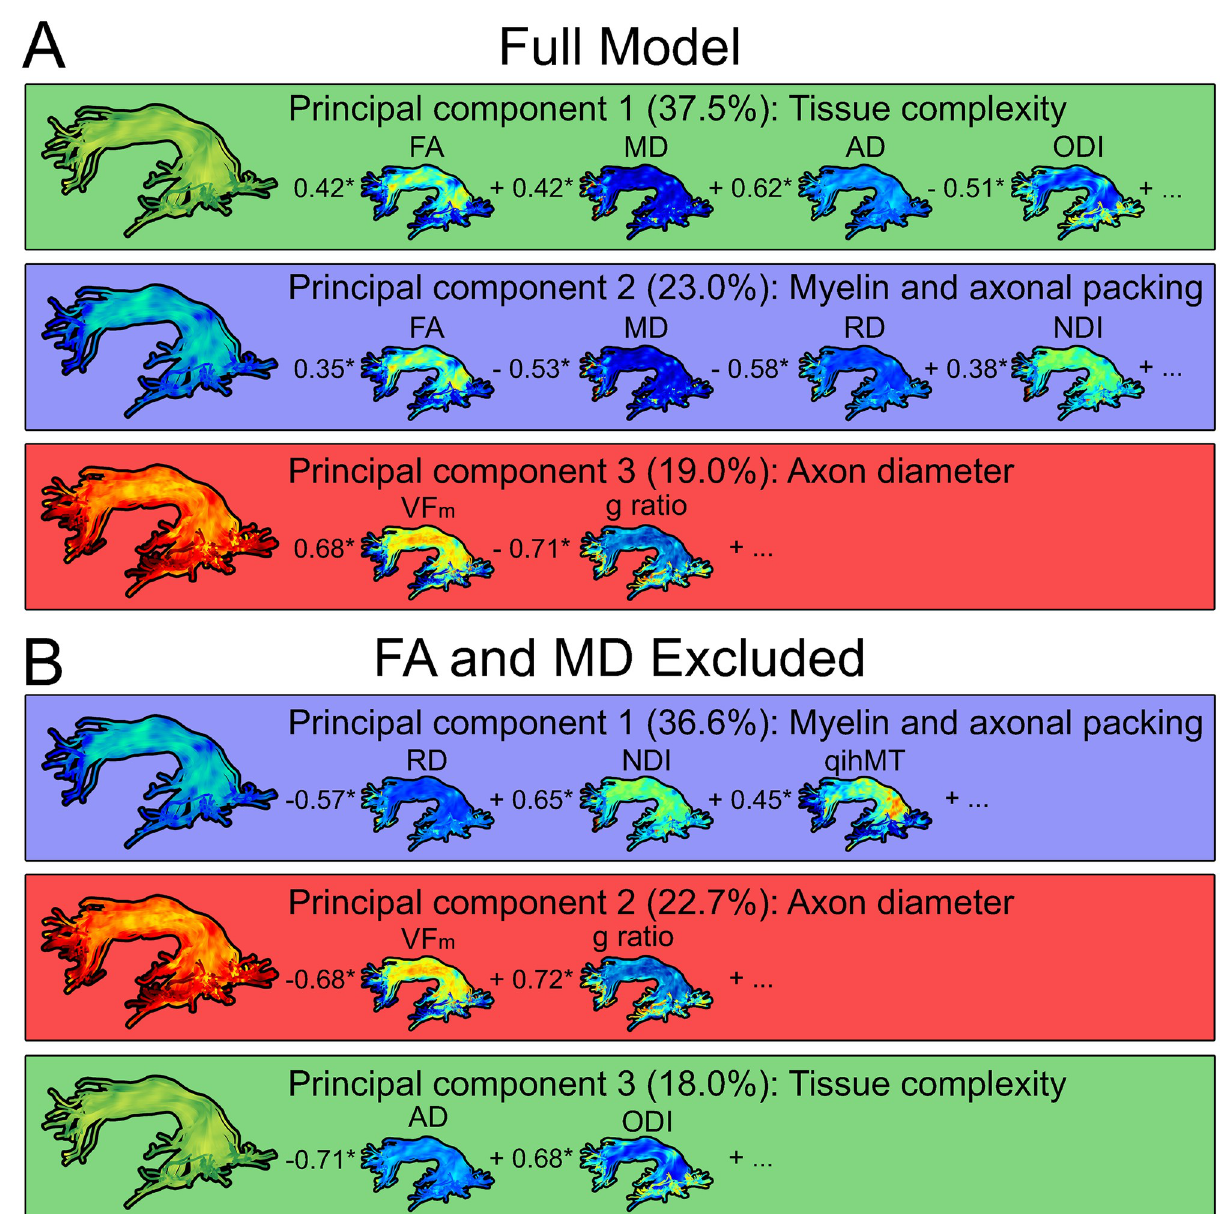
Fig 4. Principal components visualized in the left arcuate fasciculus. Correlations for measures which contribute greater variance than expected by chance ( > 11.1%) are included for each component. Panel A displays PCA results from all 9 measures. Components in Panel A explained 79.5% of variance in our data (variance explained by each individual component is noted in brackets). Principal components were related to diffusion along a primary axis (PC1), myelin and axonal packing (PC2), and axon diameter (PC3). Panel B shows results from a secondary PCA with FA and MD removed, as they loaded onto multiple components. Principal components in Panel B explain 77.3% of